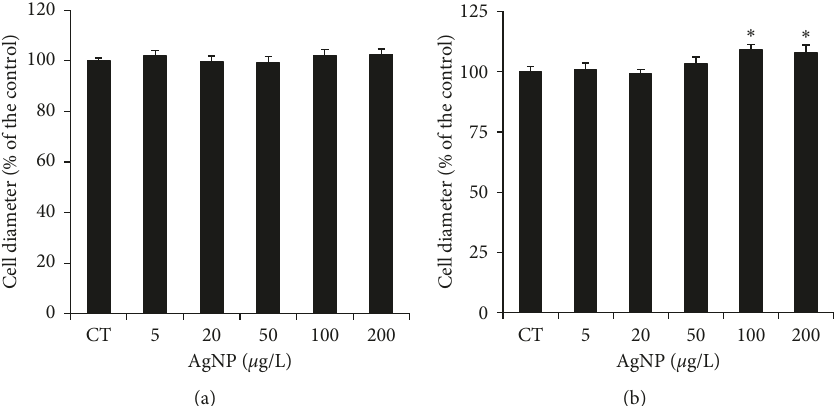
Figure 3: Algal cell diameter ( μ m) of (a) Scenedesmus sp. and (b) Thalassiosira sp. upon exposure to silver nanoparticles. Asterisks indicate significant differences compared with the control ( ∗ P < 0 .